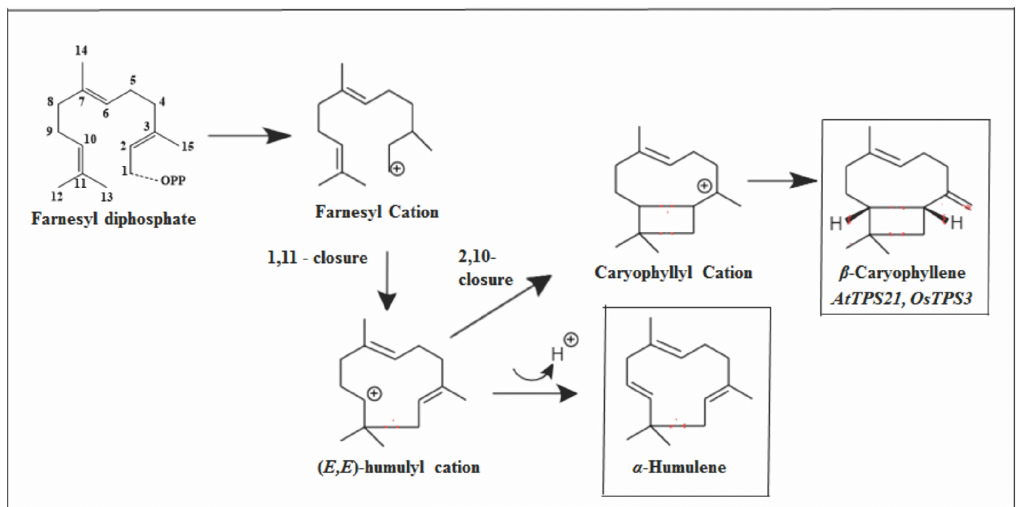
Figure 5. Types of primary cyclization of α -humulene and β -caryophyllene.